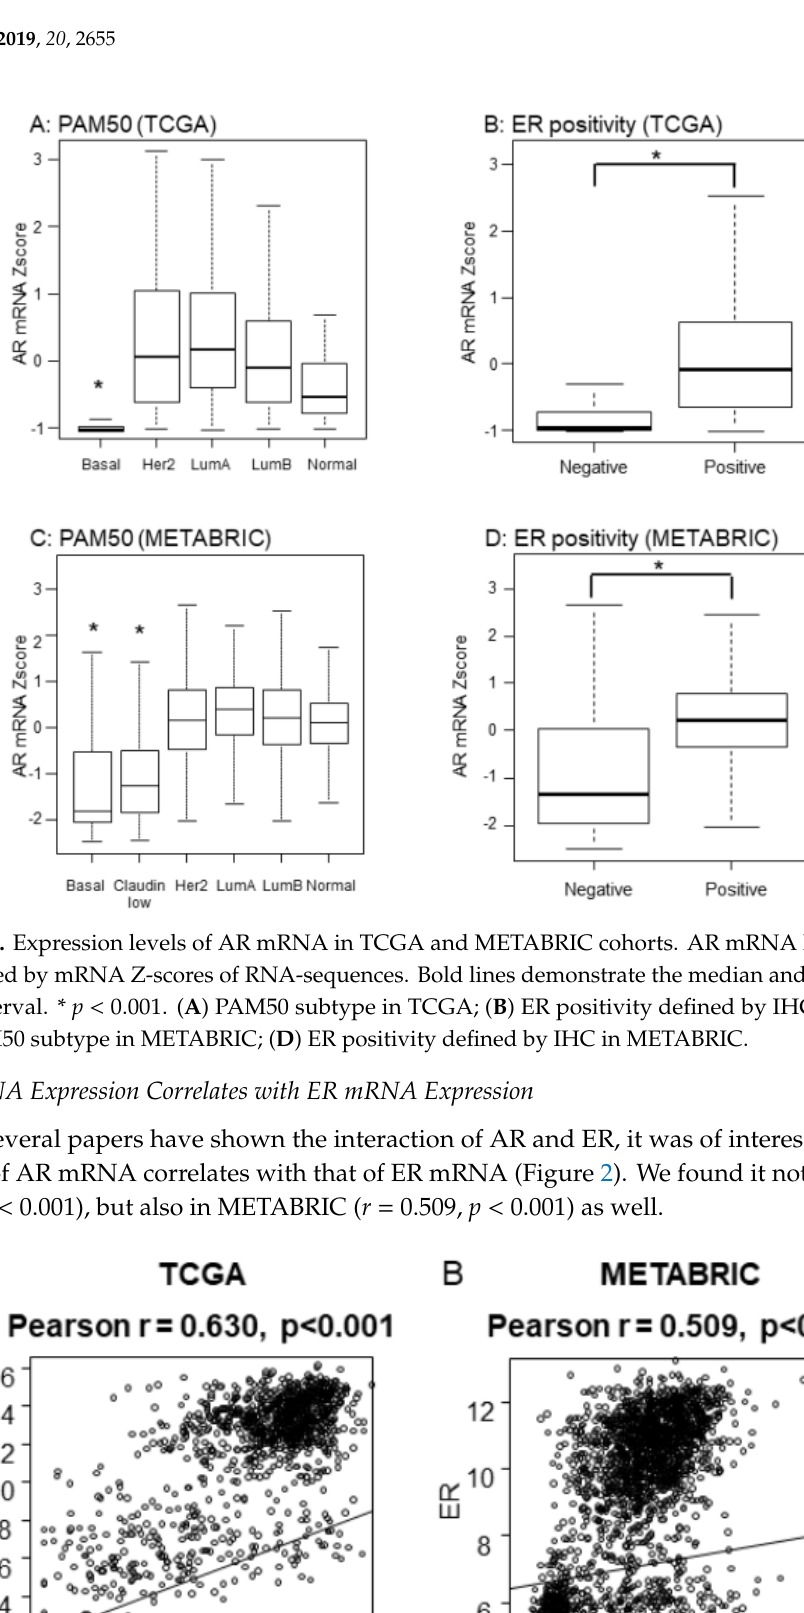
Figure 2. Pearson correlation coefficient (r) and p -value (p) between AR mRNA expression and ER mRNA expression. ( A ) A scatter plot of TCGA cohort; ( B ) A scatter plot of METABRIC cohort.